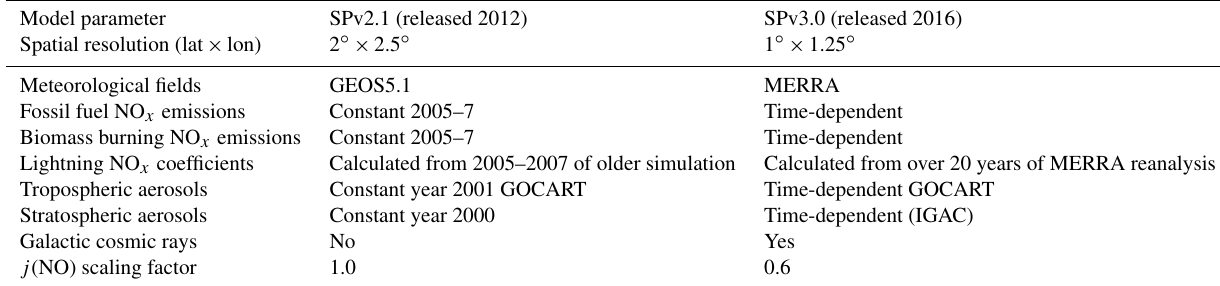
Table 1. GMI model specifications used in SP NO 2 retrieval. Model